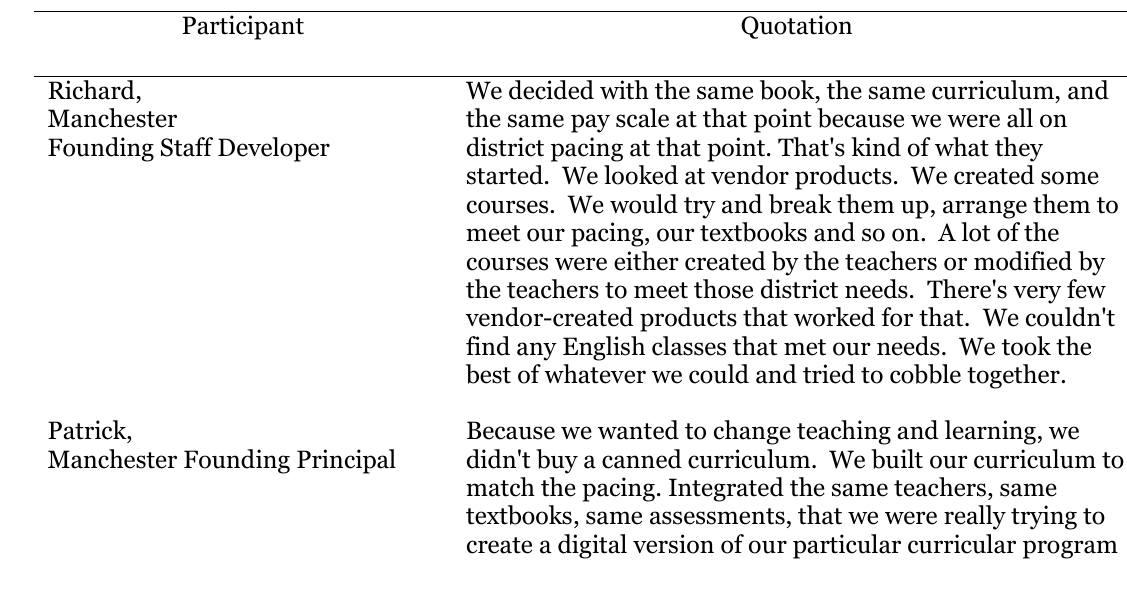
Cascading Quotes about Developing Curriculum as a Foundation Process at Manchester Participant